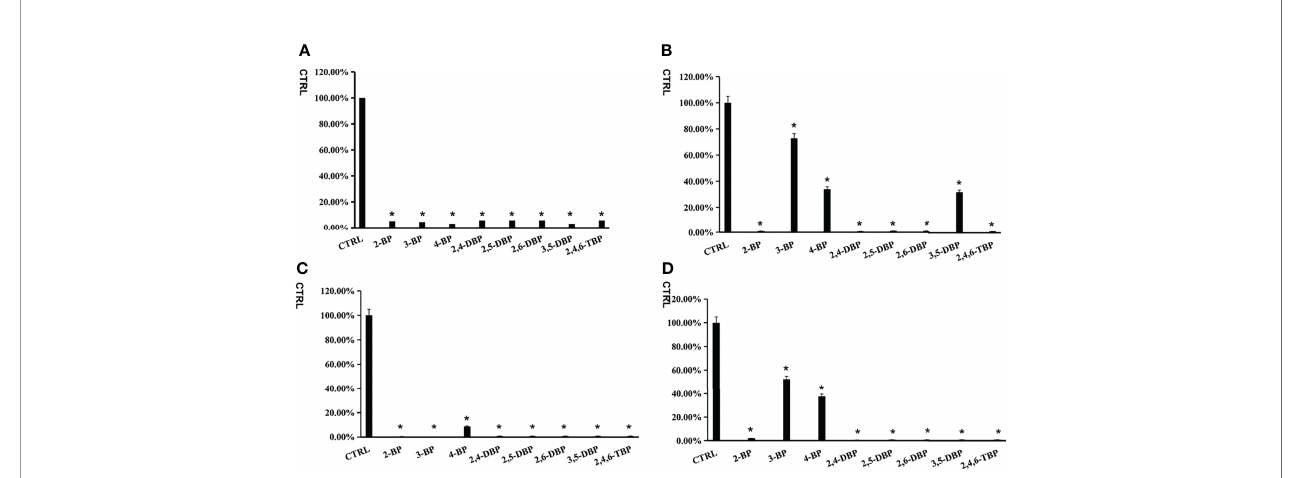
FIGURE 1 | The inhibition screening of bromophenols towards SULT1A1 (A) , SULT1A3 (B) , SULT1B1 (C) and SULT1E1 (D) . The data were given as mean value plus S.D. (n=3).*p <